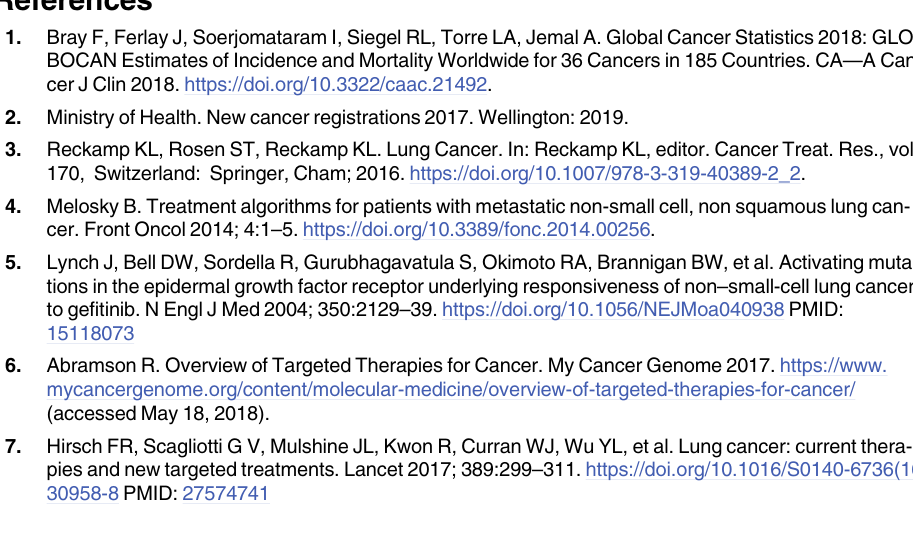
S2 Fig. Age standardised incidence rates (estimated for 100% testing) of non-squamous NSCLC in terms of EGFR mutation status categorised by gender, ethnicity and smoking status. Age standardised rates represent cases per 100,000 person-years and are based on WHO world standard population. Analysis based on total 3815 non-squamous NSCLC; lim- ited to 3776 in analyses by ethnicity; and limited to 1855 in analyses by smoking status due to missing data. Ever-smokers comprised current smokers and former smokers. The vertical error bars represent 95% confidence intervals of incidence rates. S1 Table. WHO world standard population. S2 Table. Numbers of resident population, shown by smoking status, based on 2013 New Zealand census data. S3 Table. Different types of EGFR mutation by numbers of